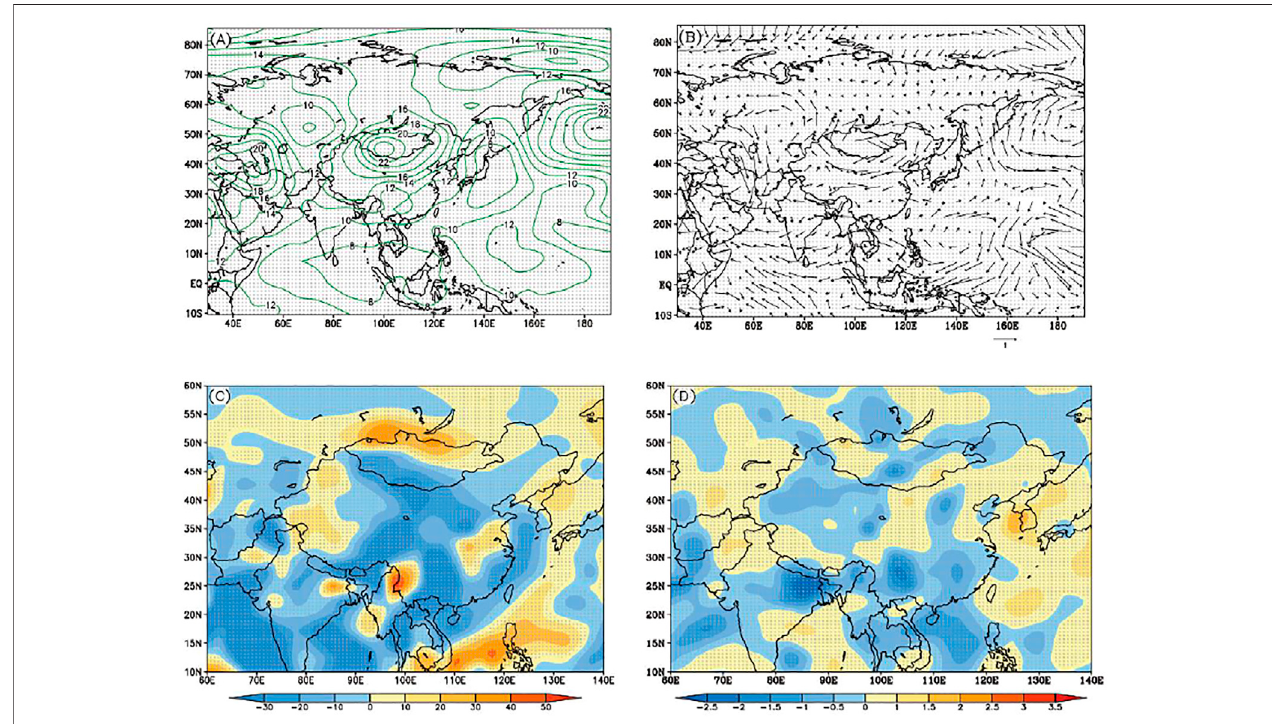
FIGURE 7 | Difference in (A) geopotential height, (B) wind at 500 hPa, (C) vertically integrated water vapor fl ux (surface to 300 hPa), and (D) vertically integrated water vapor fl ux divergence (surface to 300 hPa) between 1993 – 2021 and 1968 – 1992. Gray dots indicate signi fi cance at the 0.05 level (two-tailed Student ’ s t-test).